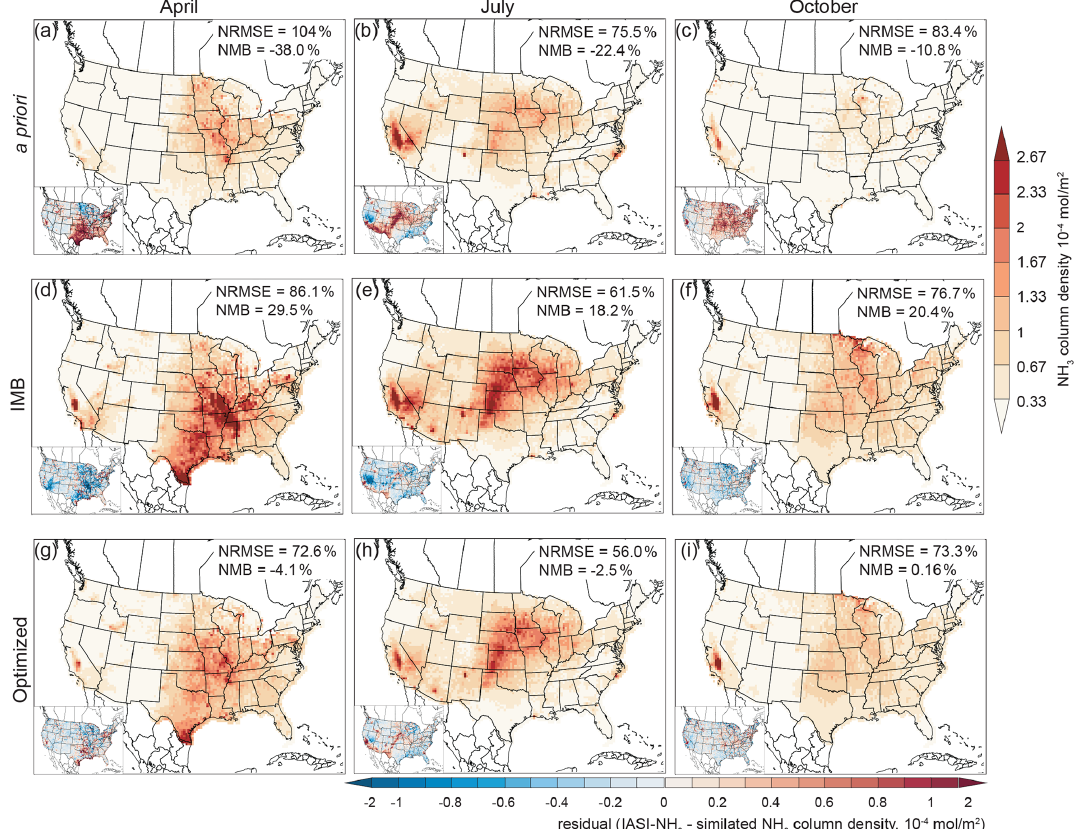
Figure 2. CMAQ-simulated monthly average NH 3 column density for April, July, and October 2011 using the a priori emissions (a, b, c) , the emissions adjusted by IMB (d, e, f) , and the final optimized emissions using the hybrid approach (g, h, i) . For comparison with the IASI-NH 3 retrievals, simulated NH 3 columns at the passing time were derived when there were observations in that grid cell. Normalized root mean square error (NRMSE) and normalized mean bias (NMB) between the simulated values and IASI-NH 3 are provided. Residue map (IASI-NH 3 − simulated NH 3 column densities) is shown in the corner of each